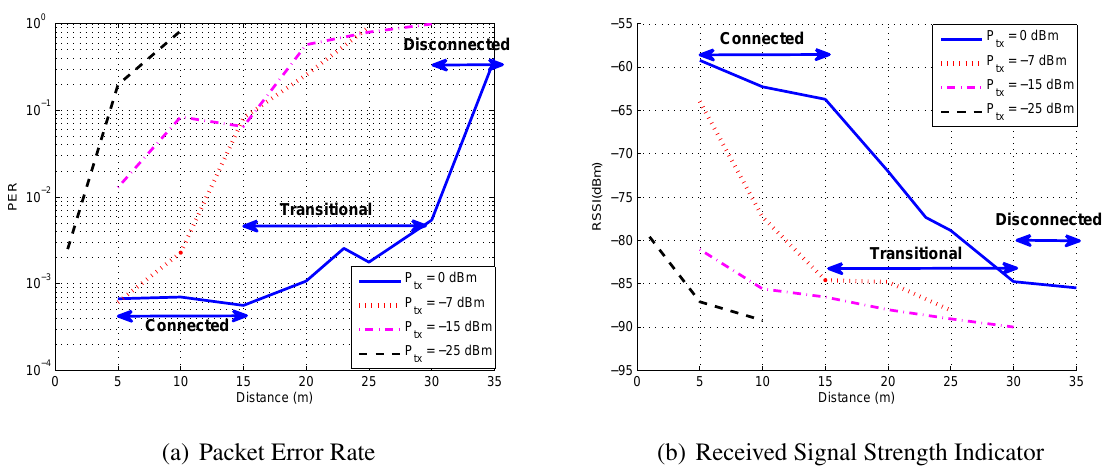
Figure 3. PER and RSSI against distance for different transmission powers. Corridor